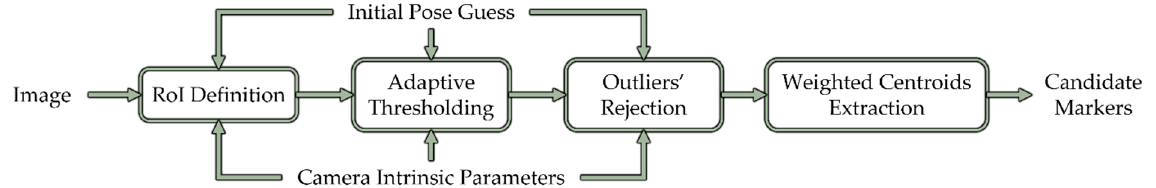
Figure 10. Flow chart for the detection step of the algorithm for pose estimation with the eye-in-hand camera.